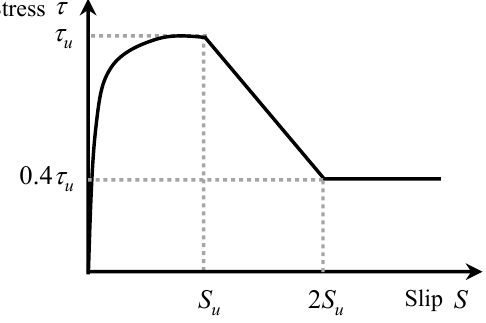
Figure 16. Bond-slip model between concrete and reinforcement.